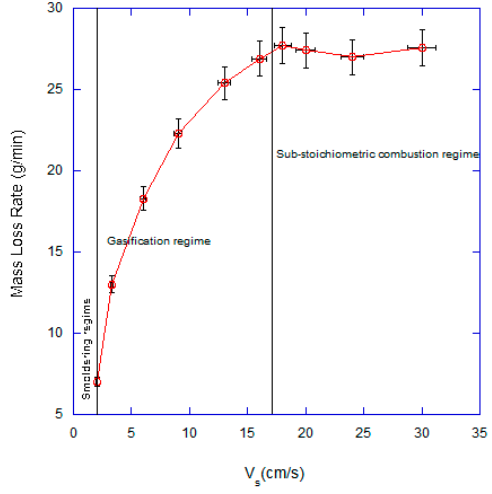
Figure 3. Effect of the superficial velocity on the mass loss rate.